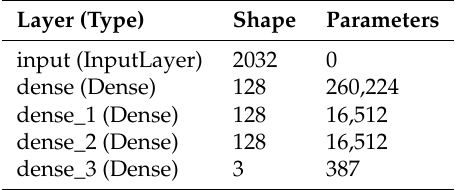
Table 1. Neural network layer configuration information of the MLP used in the